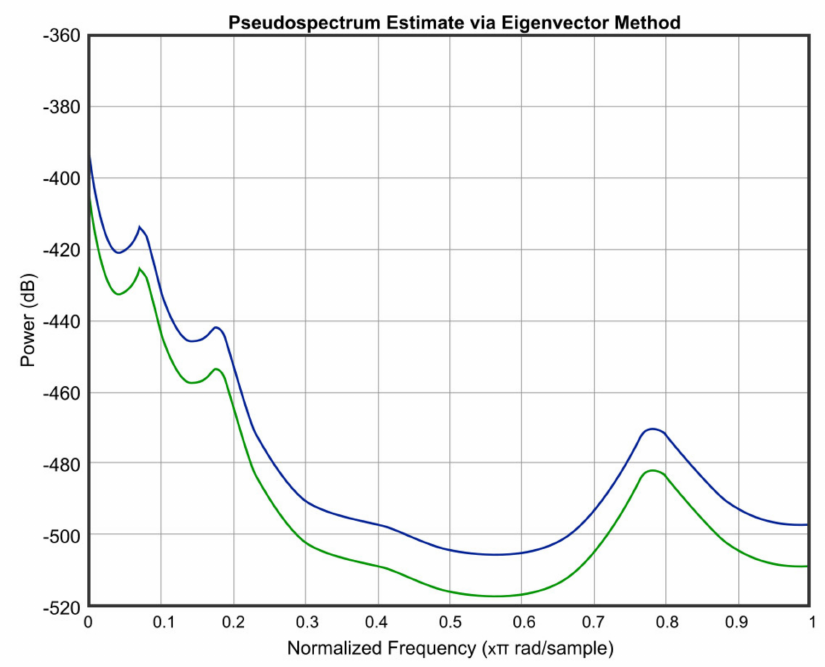
Figure 15. Signal behavior at T = 0 ◦ C and RH = 0% (blue) compared to T = − 20 ◦ C and RH = 60%